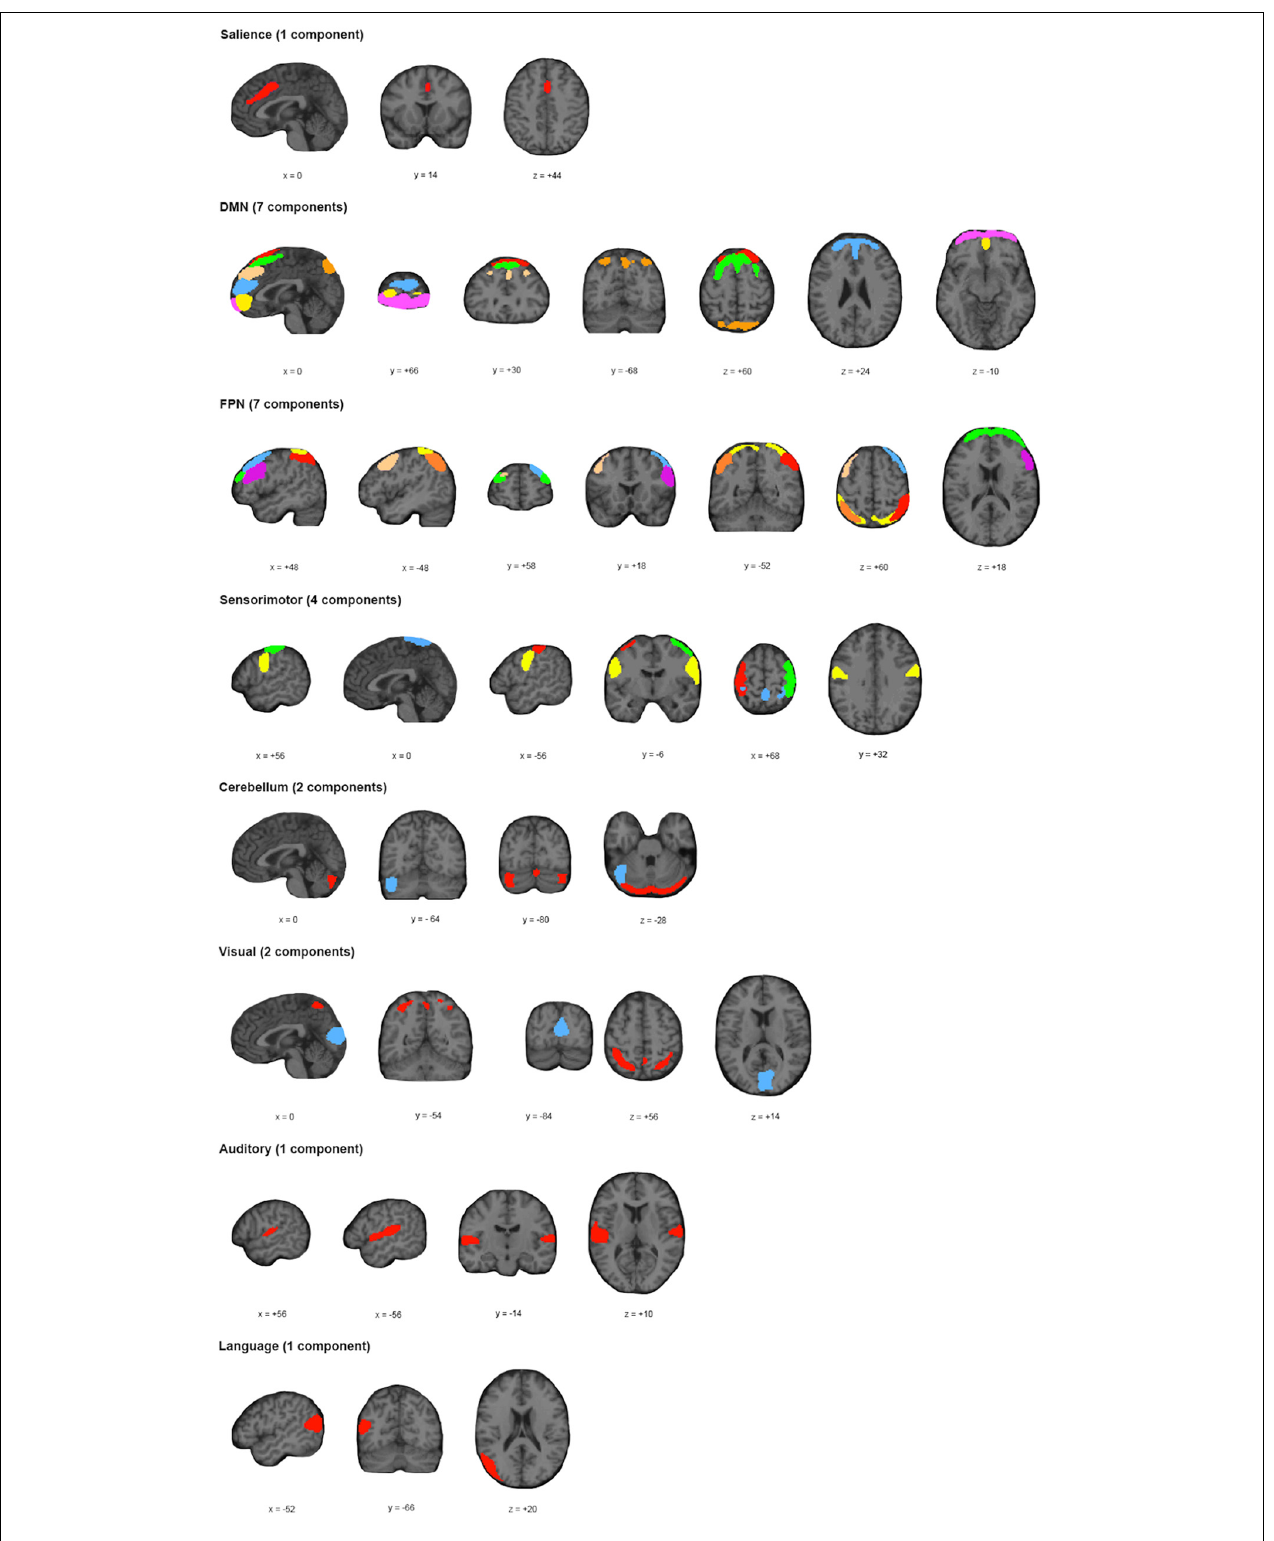
FIGURE 2 | Spatial Location and Classification of Independent Components. A total of 25 independent components (ICs) were extracted from the dataset and subsequently classified into 8 known networks: salience network (Sa); default mode network (DMN); frontoparietal network (FPN); sensorimotor network (SM); cerebellar network (Ce); visual network (Vi); language network (La); or auditory network (Au). The color scheme allows for differentiation of components within a particular network; and does not represent any relationship with ICs of the same color for a different network.